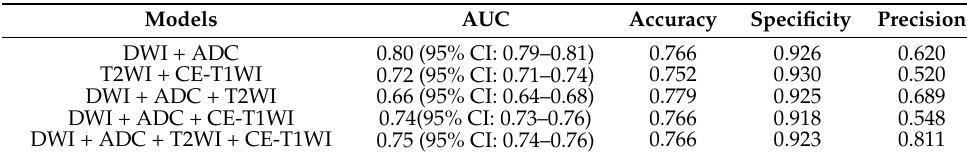
Table 2. The performance metrics for five models in the validation